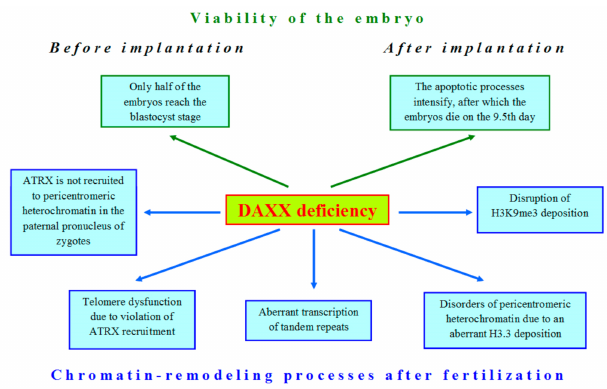
Figure 3. The deficiency of DAXX violates many cellular processes in early development of